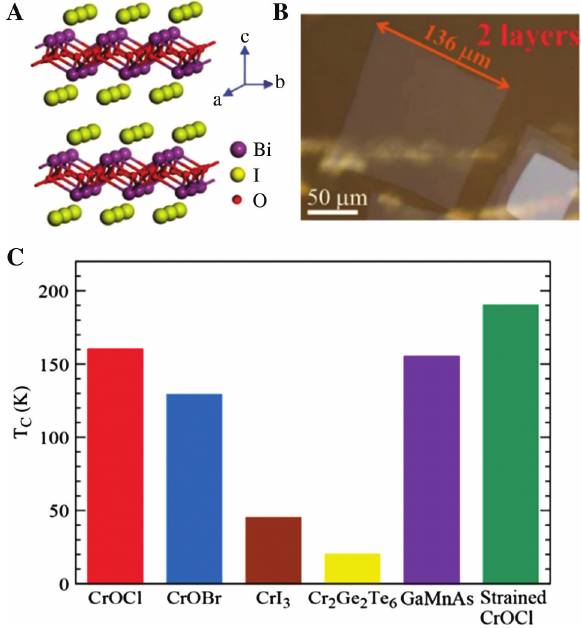
Figure 7: Structure, growth and physics of 2D BiOX and